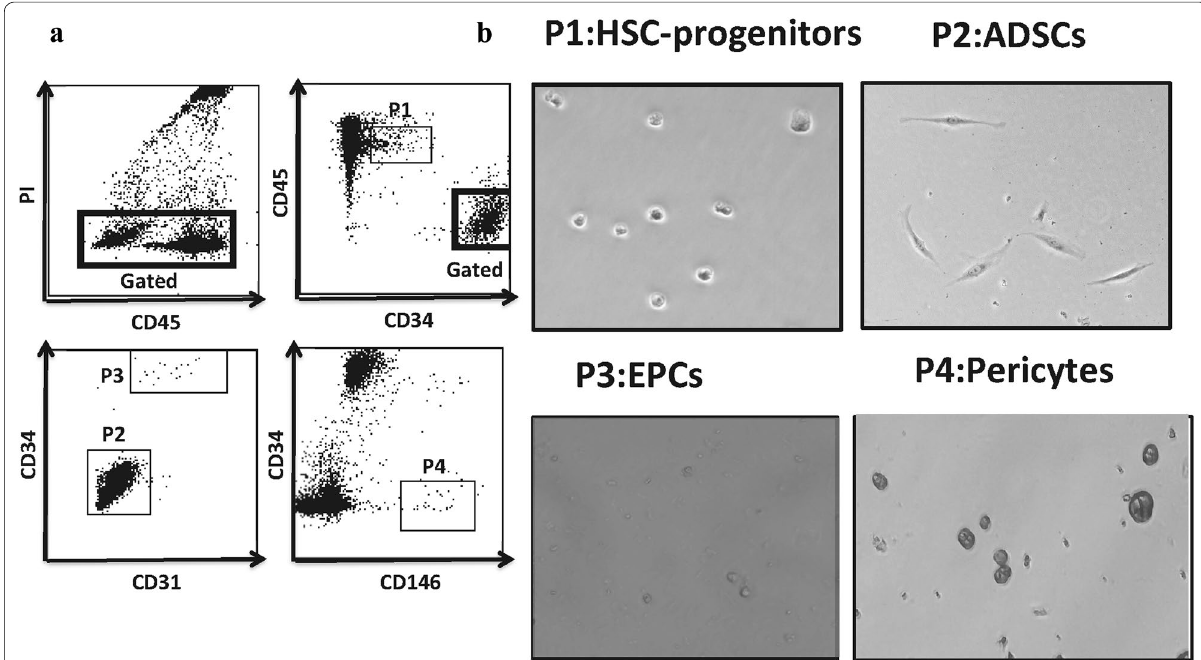
Fig. 6 Analyzing the source of culture expanded-mesenchymal stem cells. a The four candidate progenitor cell populations were simultaneously sorted and put into a culture according to the shown gating strategy. PI negative live cells were gated. Each region shows sorted population (P)